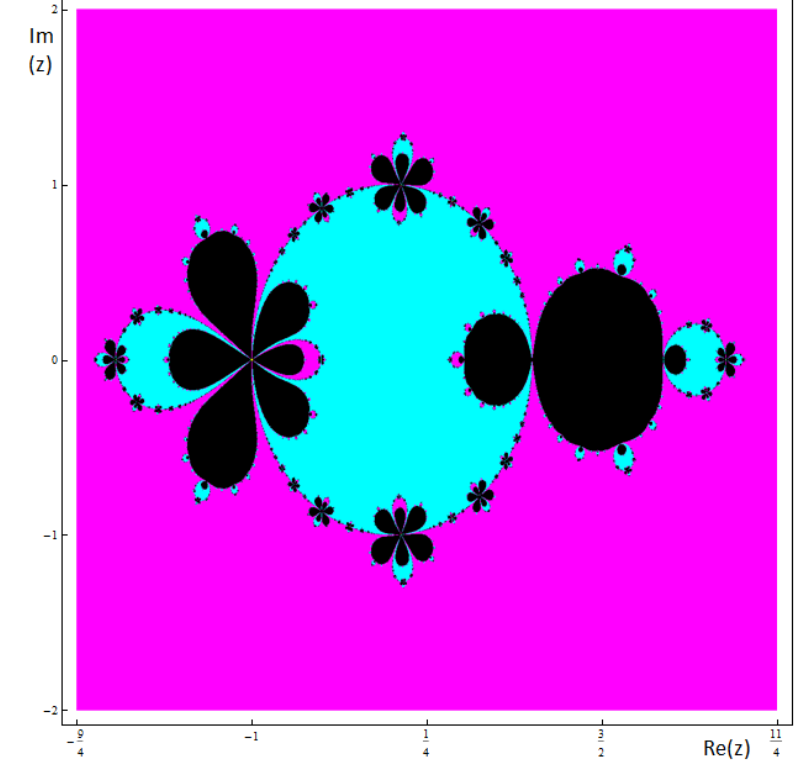
Figure 8. Basins of attraction associated to the member of the family a 0 = 2.75 and a 1 = −